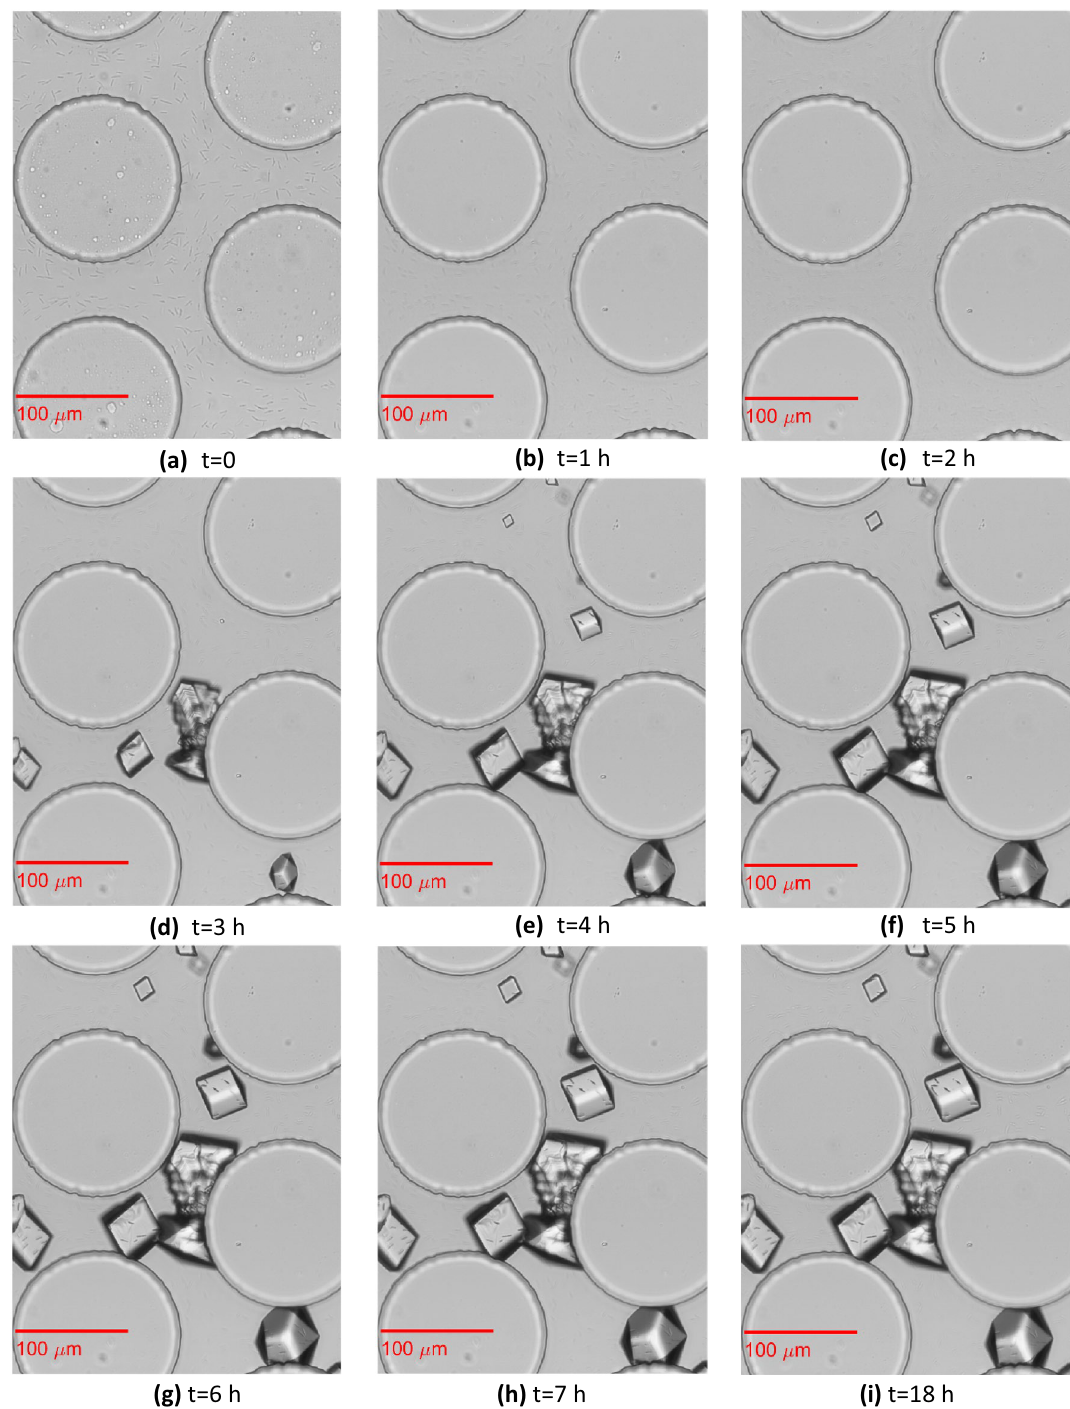
Figure 7. The growth of single crystals and crystal aggregates in selected pores of the homogeneous microfluidic chip captured ~423 mm from the